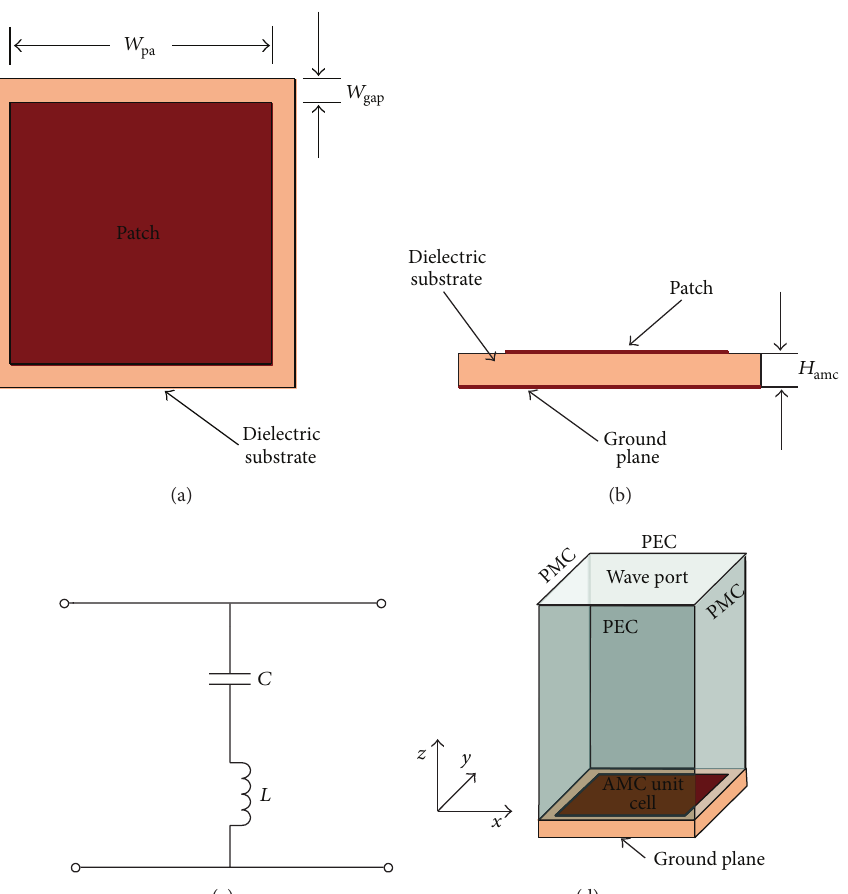
Figure 2: A unit cell of AMC structures with a square patch. (a) Front view. (b) Side view. (c) Equivalent circuit. (d) Simulation model.